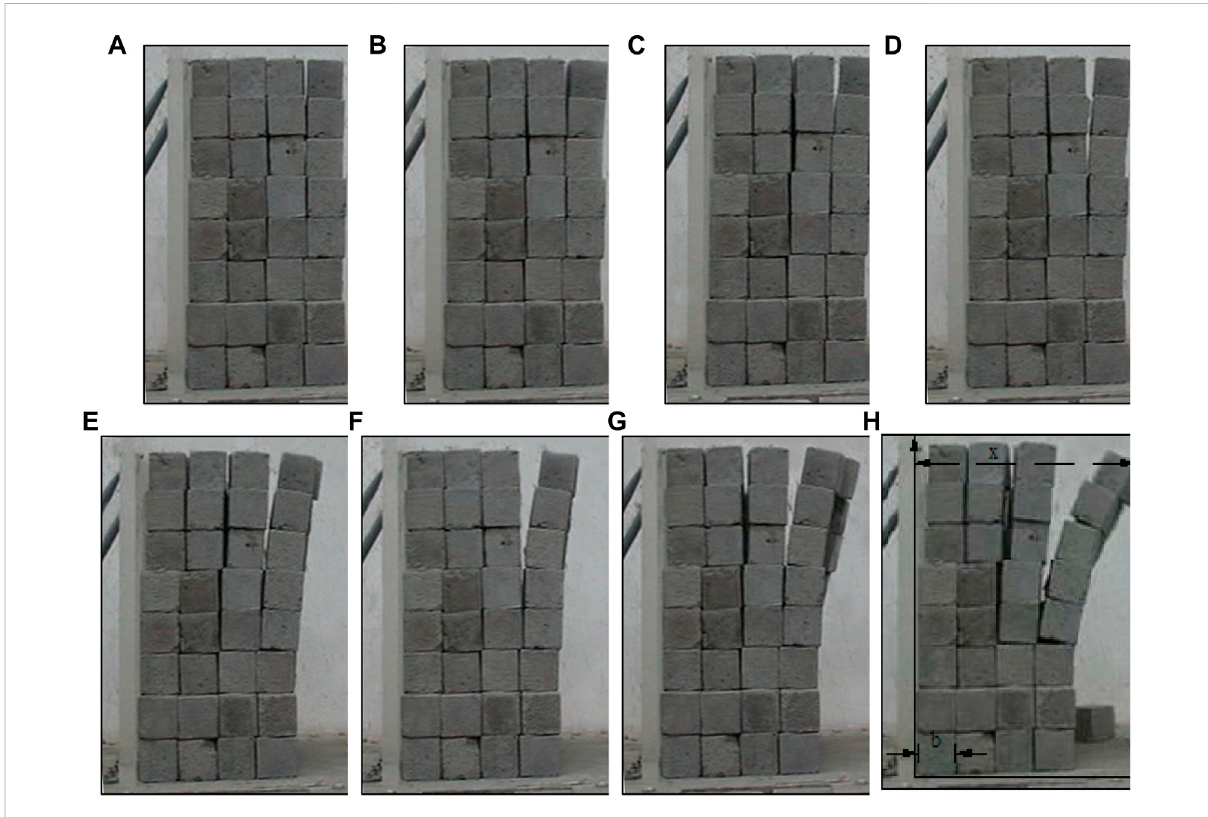
FIGURE 7 Failure forms at different times of the dangerous rock block. (A) t = 0.2 s. (B) t = 0.4 s. (C) t = 0.8 s. (D) t = 1.2 s. (E) t = 1.6 s. (F) t = 1.8 s. (G) t = 2.0 s. (H) t = 2.2